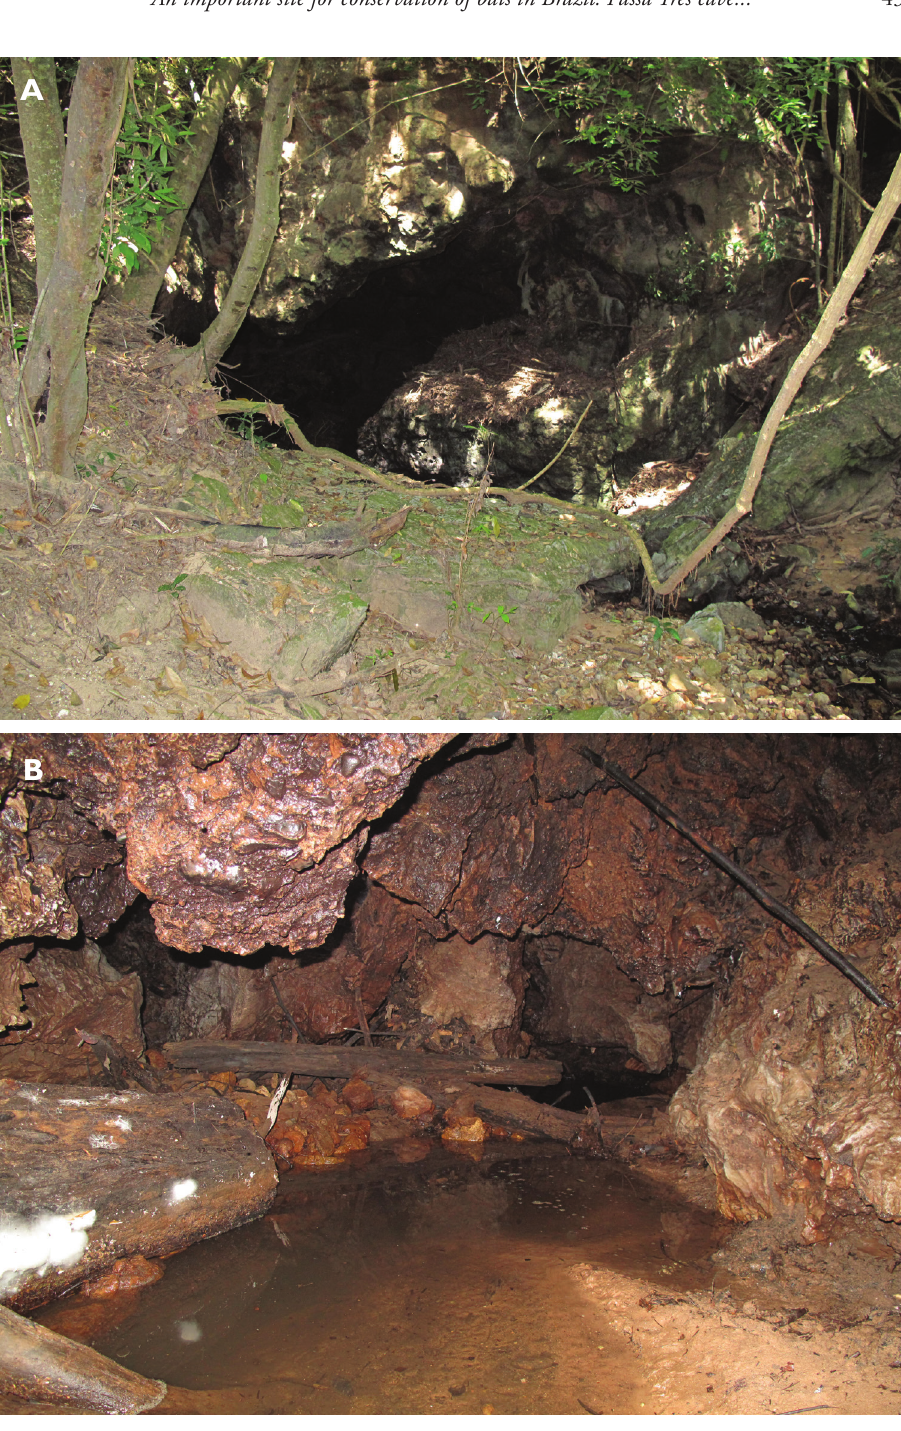
Figure 2. Passa Três cave, São Domingos karst area, Goiás state, central Brazil. A cave entrance B cave stream conduit close to entrance with short ceiling passages. Photos: M. E.